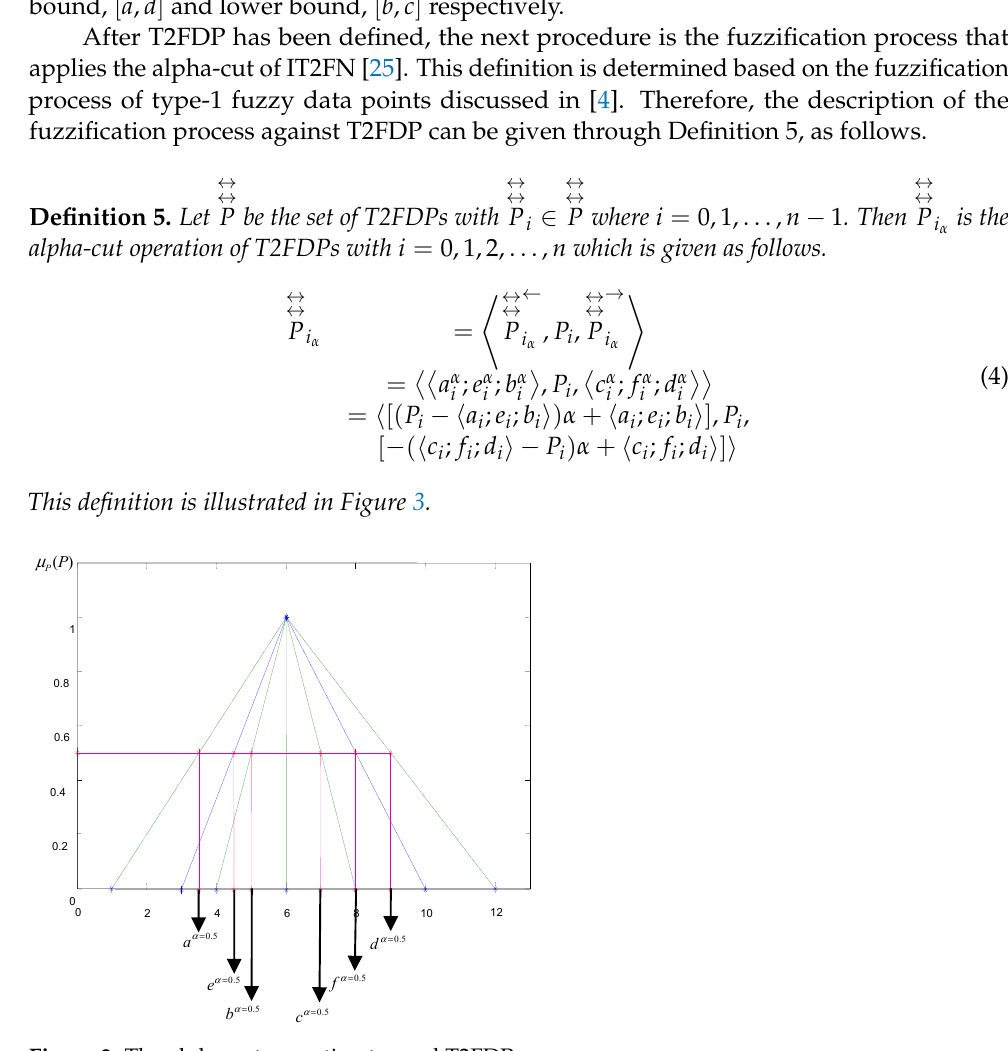
Figure 3. The alpha-cut operation toward T2FDP.